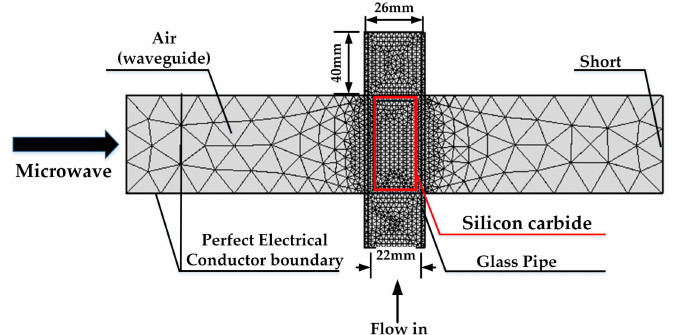
Figure 1. The geometry of the microwave